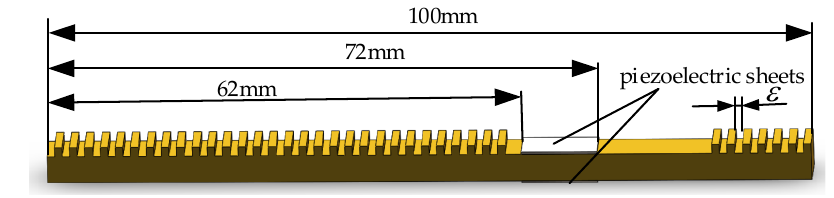
Figure 2. The dimensions of the touch beam.